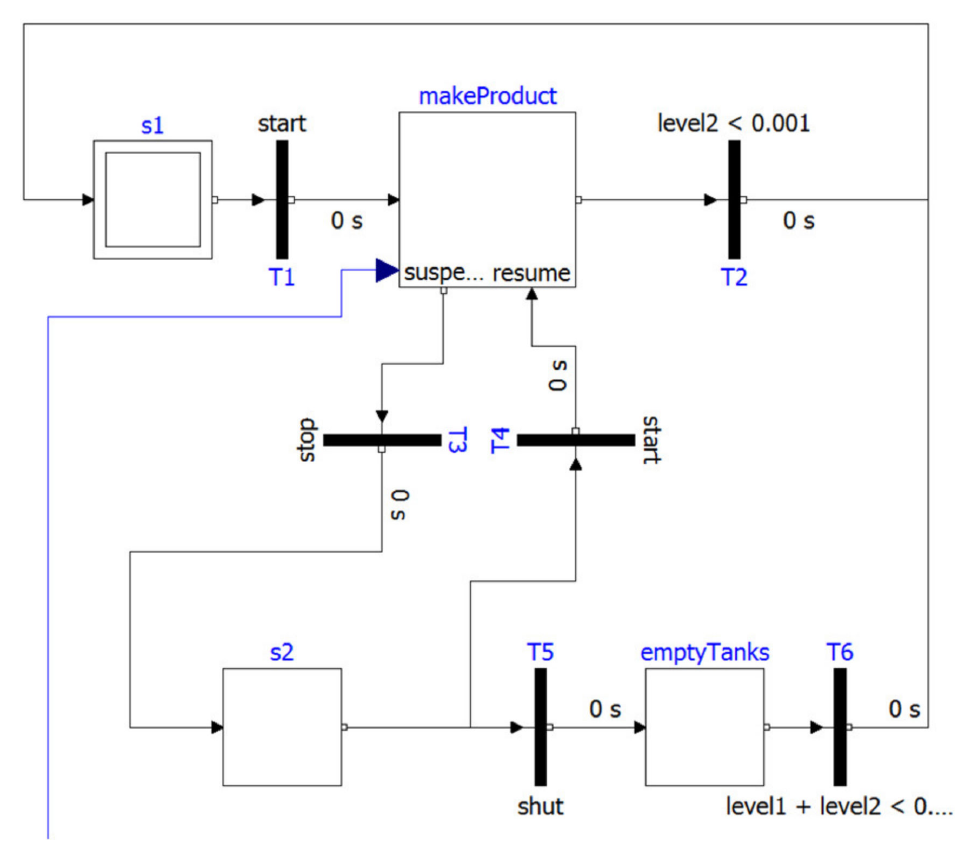
Figure 10. Control system model in the OpenModelica environment with applying the Model- ica.StateGraph